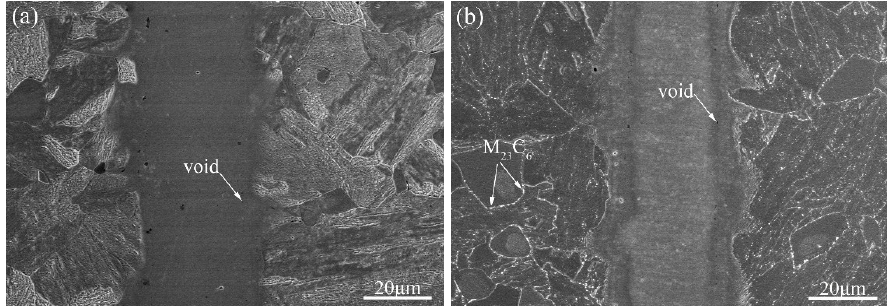
Figure 2. Microstructure of the joint interface: ( a ) prior to tempering treatment and ( b ) subject to tempering treatment.